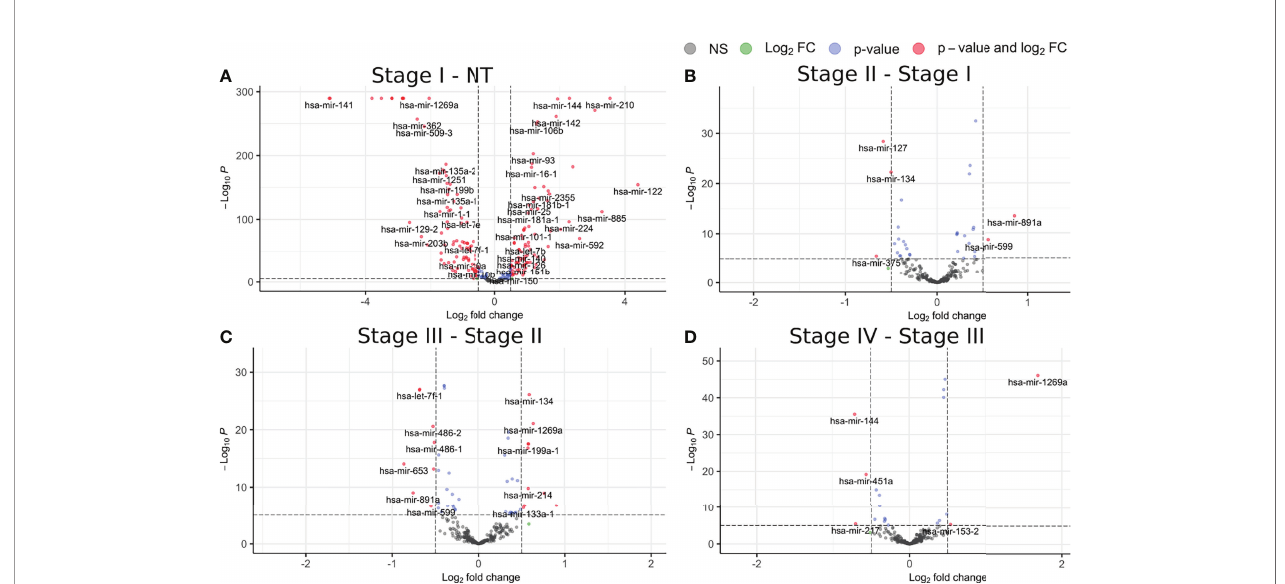
FIGURE 3 | Differentially expressed miRs for each contiguous stage of ccRC. (A) Contrast between control and stage I; (B) stage I V, stage II; (C) stage II V, stage III; (D) stage III V, stage IV. The color code is the same as that in Figure 2